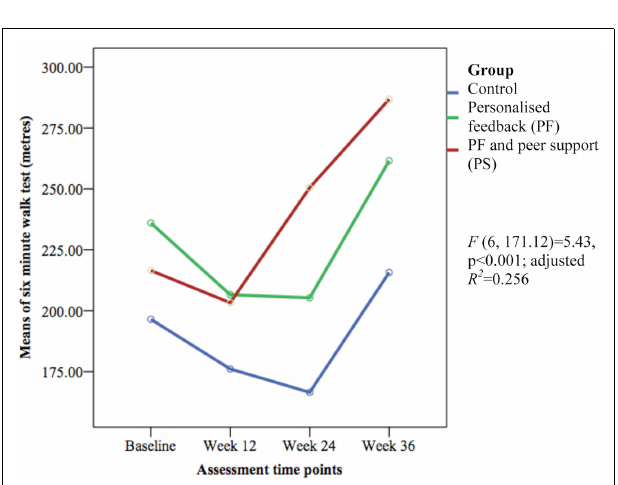
FIGURE 7 | Mean differences on distance walked in 6min between groups over time .